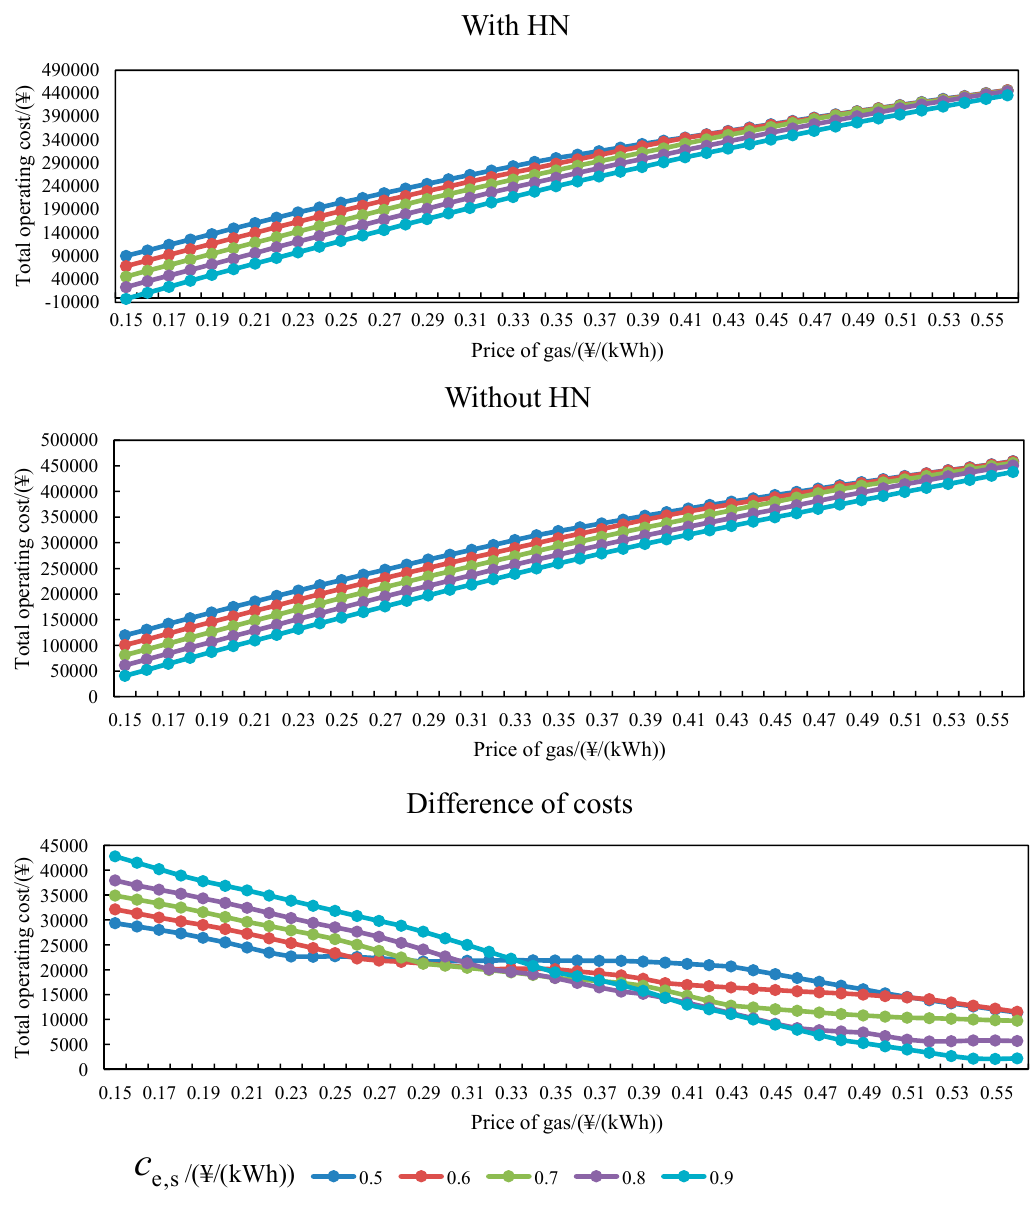
Figure 13. Sensitivity analysis of the total operating cost and the price of natural gas.